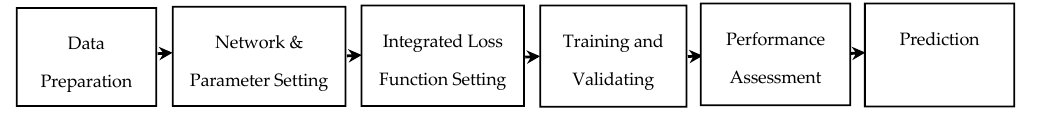
Figure 2. The methodological flow chart of this study.